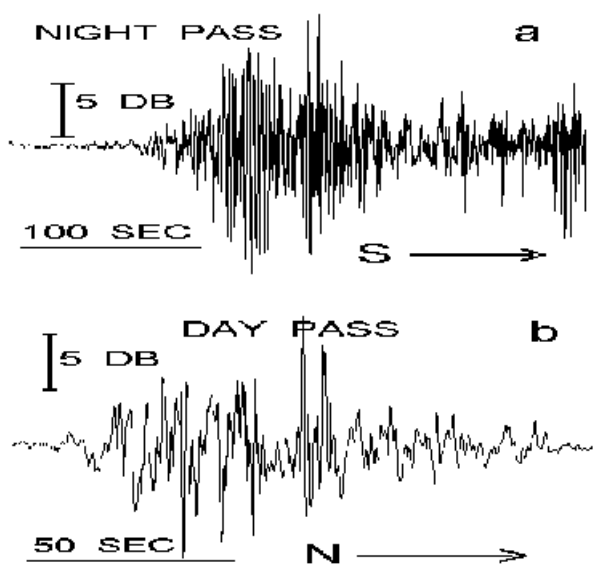
Fig. 1. Typical examples of enhanced summer scintillation activity in Far East during night (a) and day (b) . The direction of the satellite travel is indicated (south-S or north-N).